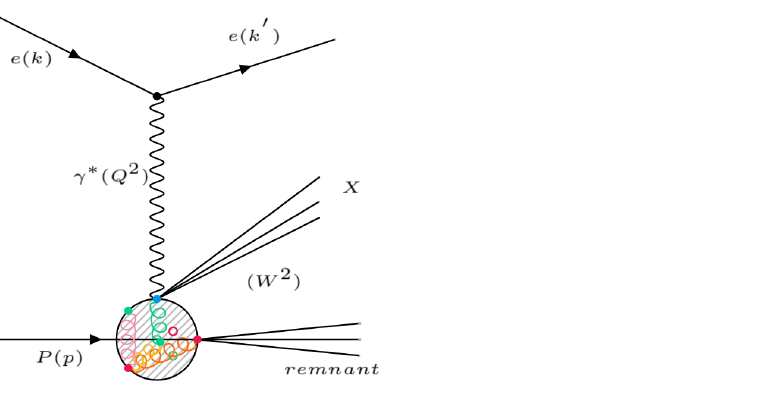
Figure 1. Graphical representation of electron–proton (ep) deep inelastic scattering (DIS) scattering. The exchanged photon γ ∗ of virtuality Q 2 couples to a quark from the proton. x is the fraction of proton’s longitudinal momentum carried by the quark. γ ∗ p center-of mass energy in the hadronic final state is denoted by W